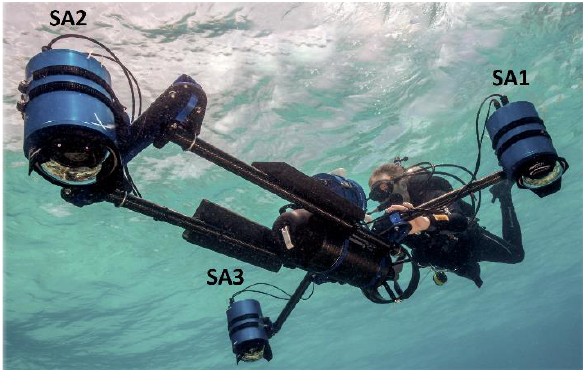
Figure 2. The SeaArray V4, a diver-operated tri-camera photogrammetry system employed in this research. In this article, the front camera is referred to as SA2, while the rear ones are respectively SA1 (left side) and SA3 (right